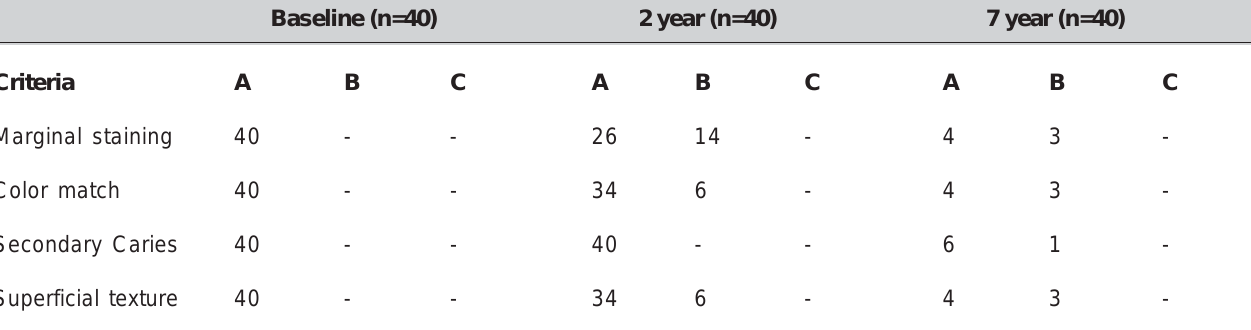
Table 1 - Clinical evaluation of packable resin after 2 and 7-year according to the